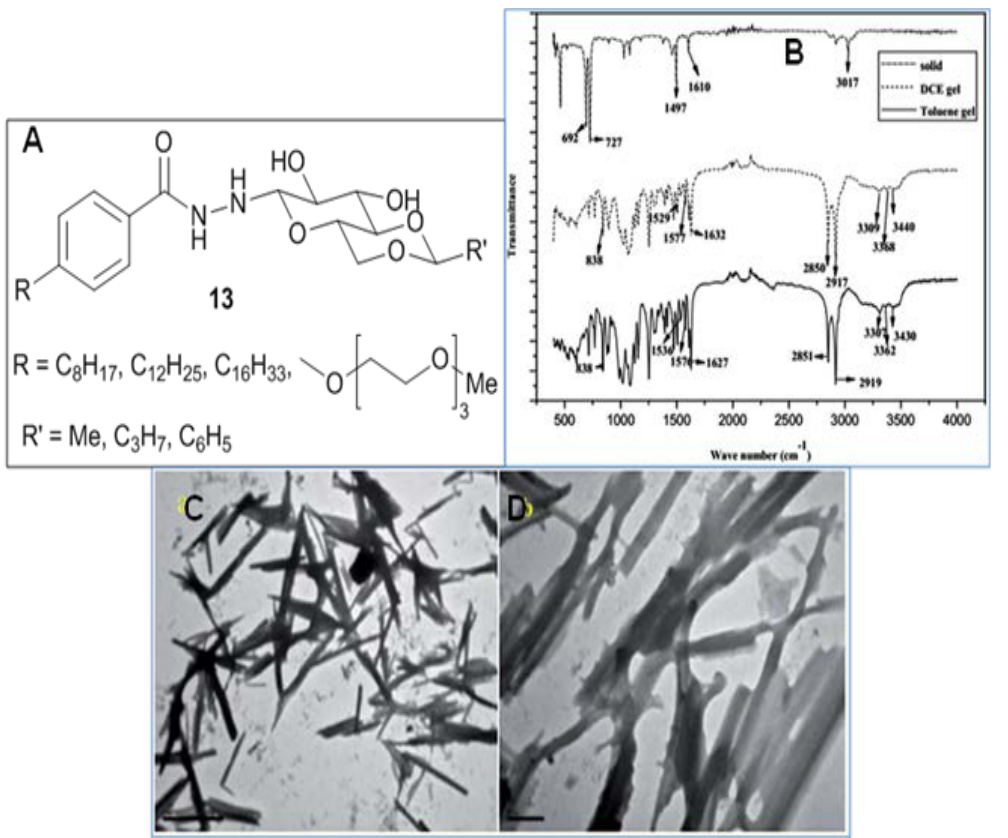
Figure 11. ( A ) Structures of gelators; ( B ) FTIR spectra of compound 13 (with R = OC 8 H 17 ; R’ = CH 3 ) solid, gel (dichloroethane), gel (toluene); high-resolution transmission electron microscopy (HR-TEM) images of this compound (dissolved in dichloroethane) under different magnifications: ( C ) 1 mm and ( D ) 0.5 mm. Reprinted with permission from [74]. Copyright 2016 Royal Society of Chemistry.